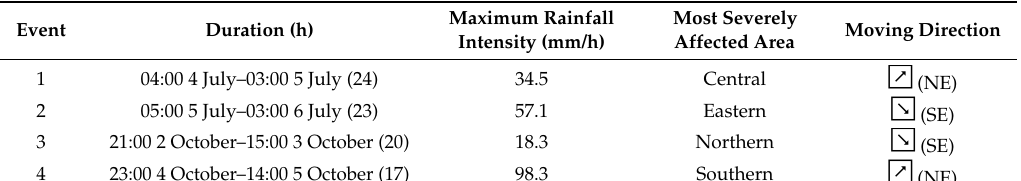
Table 1. Basic characteristics of four storm events that occurred in 2016.